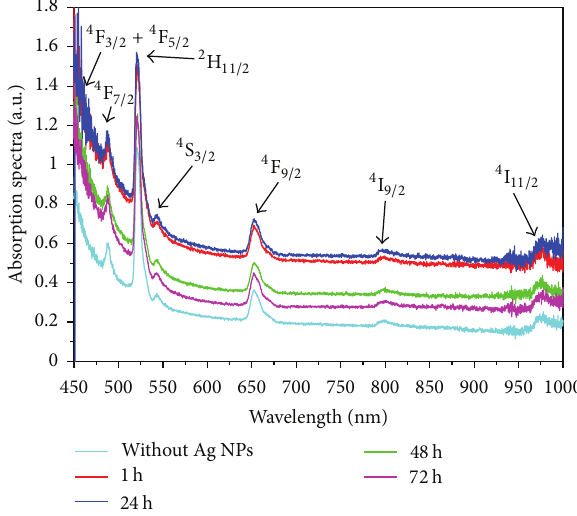
Figure 11: TEM images of the samples heat-treated during 48h [3].